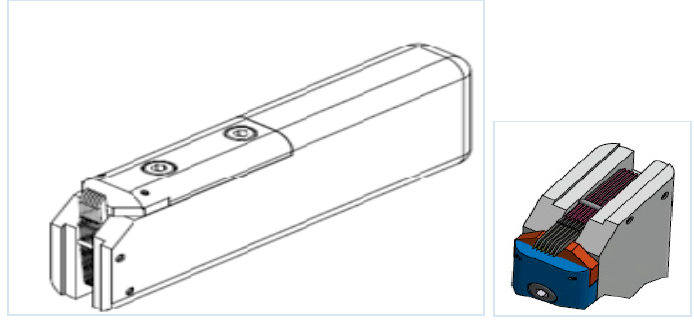
Figure 2. Schematic diagram of a hand-held cutting tool.